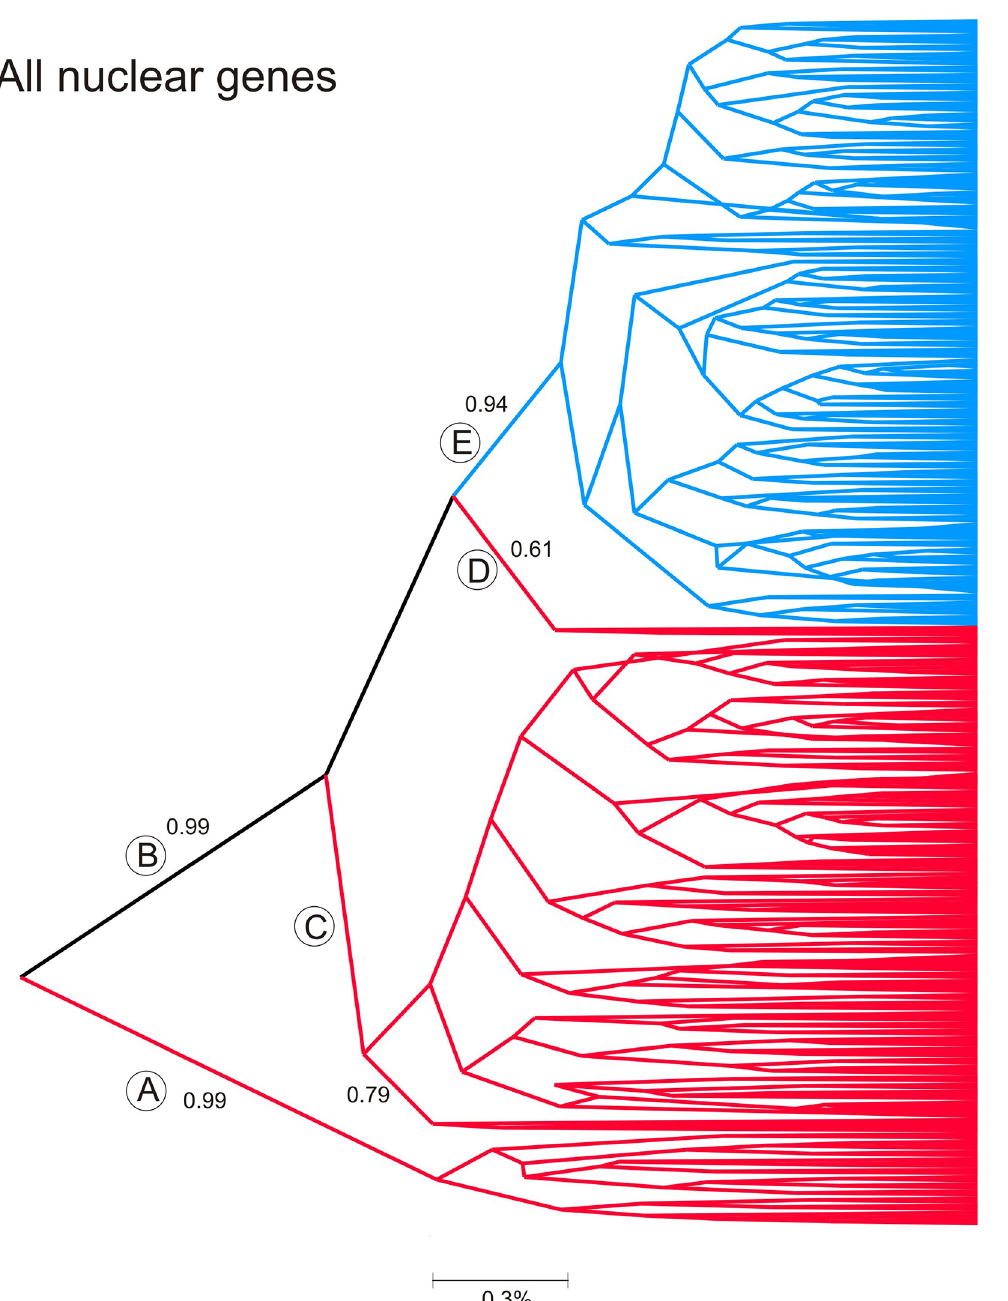
Fig 5. Maximum clade credibility coalescent tree derived all combined genes in the 338 ticks for which we obtained complete sequences in all genes. Numbers above some branches are posterior probabilities (PP) for values (cid:3) 0.90. Sequences collected exclusively in the south are colored red while those only collected in the north appear in blue. Those found in both the north and south appear in black. Any high order branches that join both north and south sequences appear in black. Some branches are labelled with a capital letter in a circle to assist discussion.